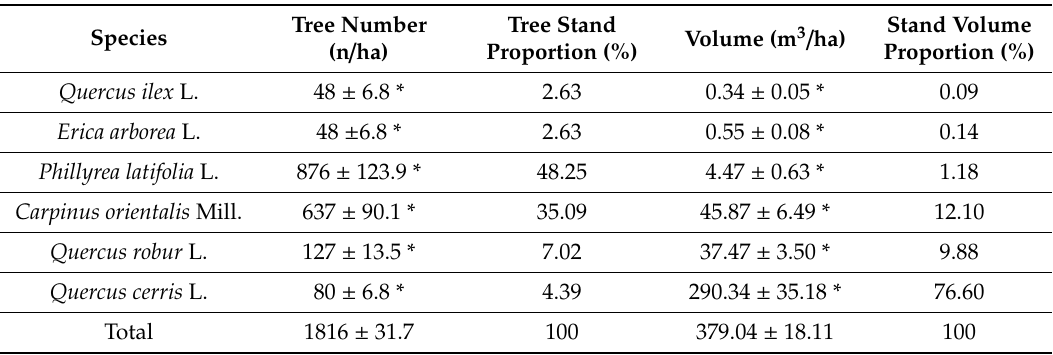
Phillyrea latifolia